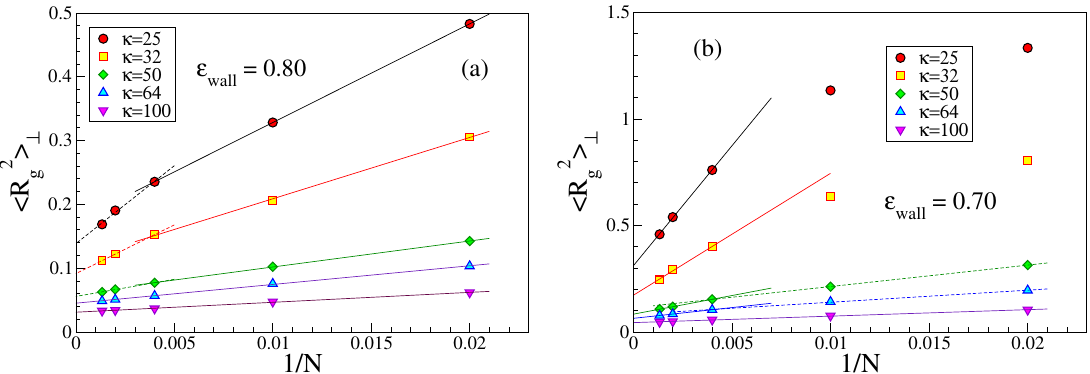
Figure 6. Plot of (cid:104) R 2 g (cid:105) ⊥ vs. 1/ N for five choices of κ , and (cid:101) wall = 0.80 ( a ); and 0.70 ( b ). Straight lines through the data are guides for the eye.